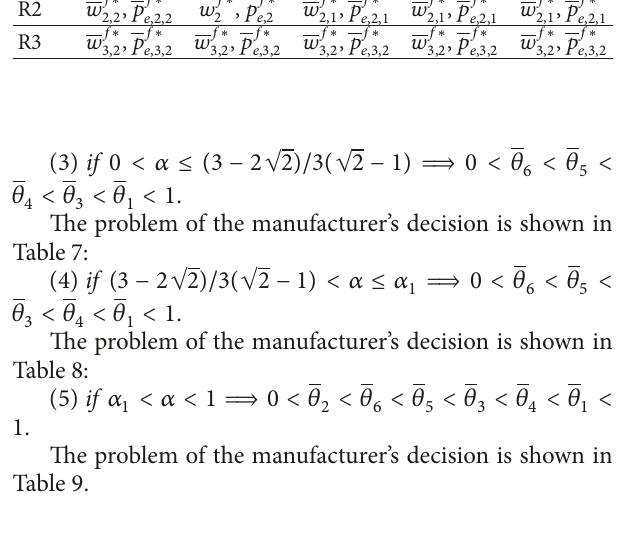
< 𝜃 < 𝜃 < 𝜃 < 𝜃 < 𝜃 < 2 6 5 3 4 1